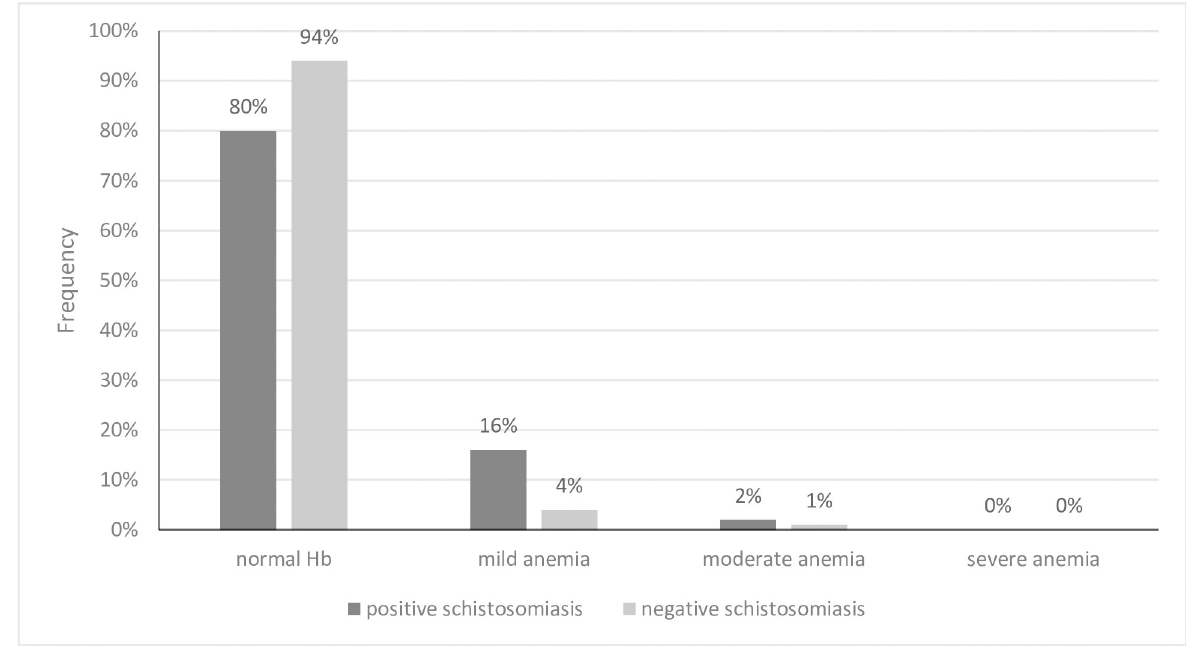
Fig 2. Anaemia Prevalence Based on Haemoglobin Levels of the Study